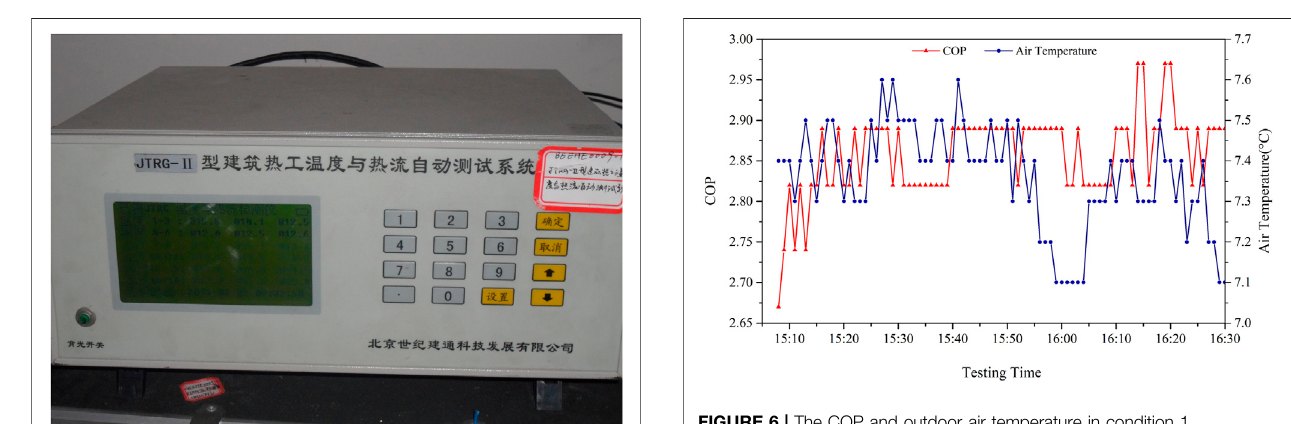
FIGURE 6 | The COP and outdoor air temperature in condition 1.